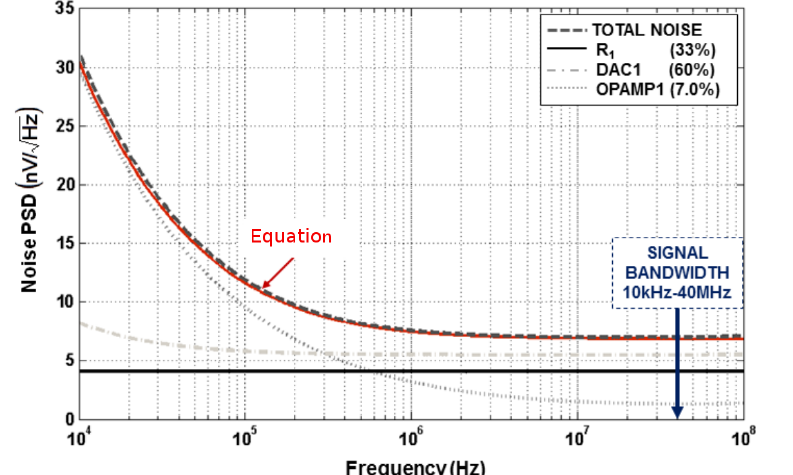
Figure 7. Breakdown of the noise contribution in the modulator